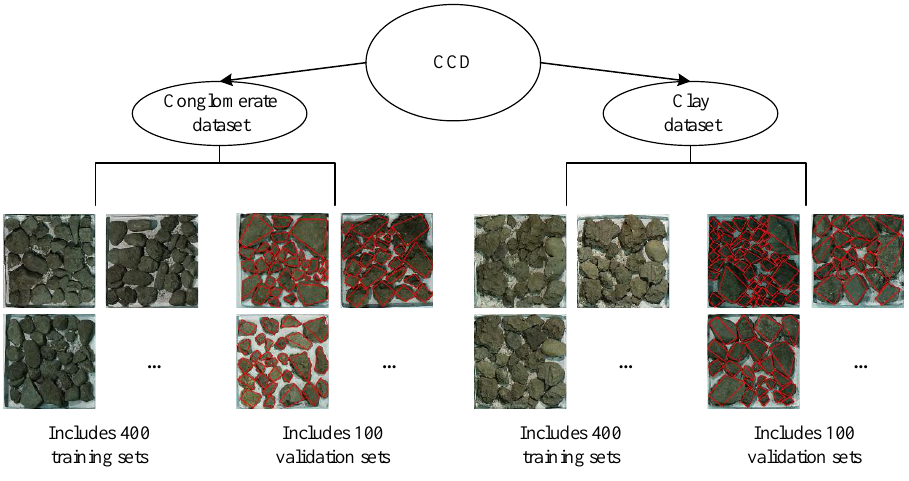
The proposed dataset CCD contains 500 conglomerate images and 500 clay images, with 400 conglomerate training sets, 400 clay training sets, 100 conglomerate validation sets, and 100 clay validation sets. Figure 6 shows our dataset.